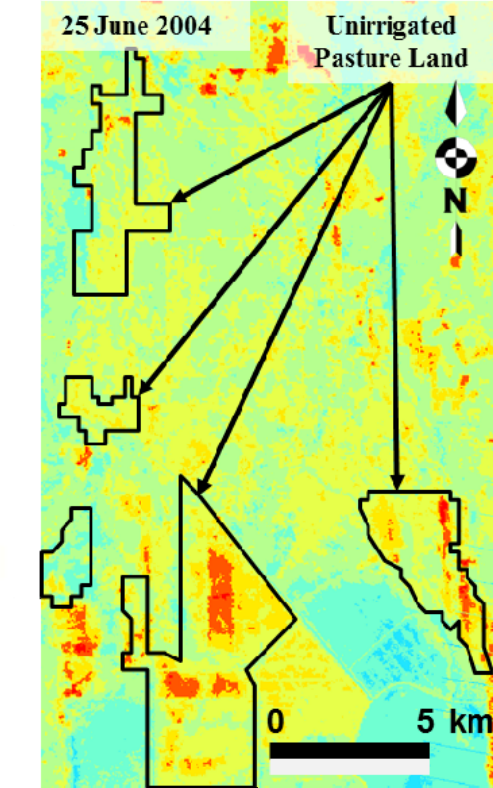
Figure 11. Contrasting Landsat evapotranspiration retrieval for 22 April (DOY 113), 25 June (DOY 177), 27 July (DOY 209) and 28 August (DOY 241) 2004 over the Wood River